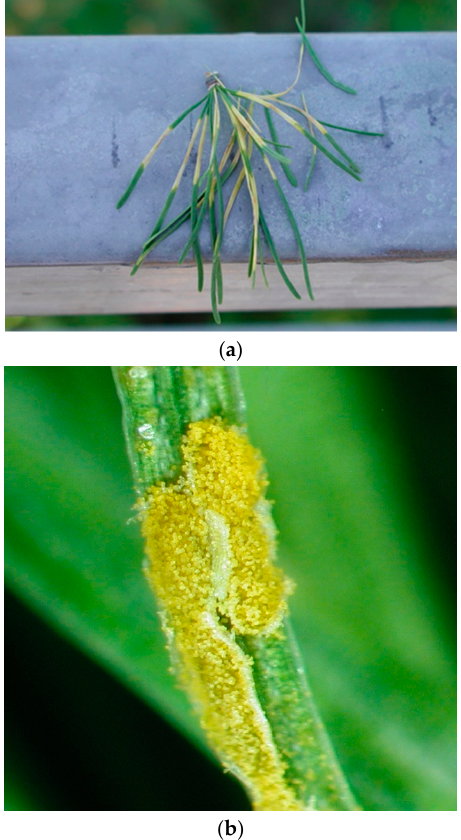
Figure 5. ( a ). Exceptionally heavy rust infection on a spur shoot of a hybrid larch sapling, Rovaniemi, 2 July 2006; ( b ) The aecial state of an unspecified rust species on a Siberian larch needle, Kivalo Research Area, 24 June 2007.